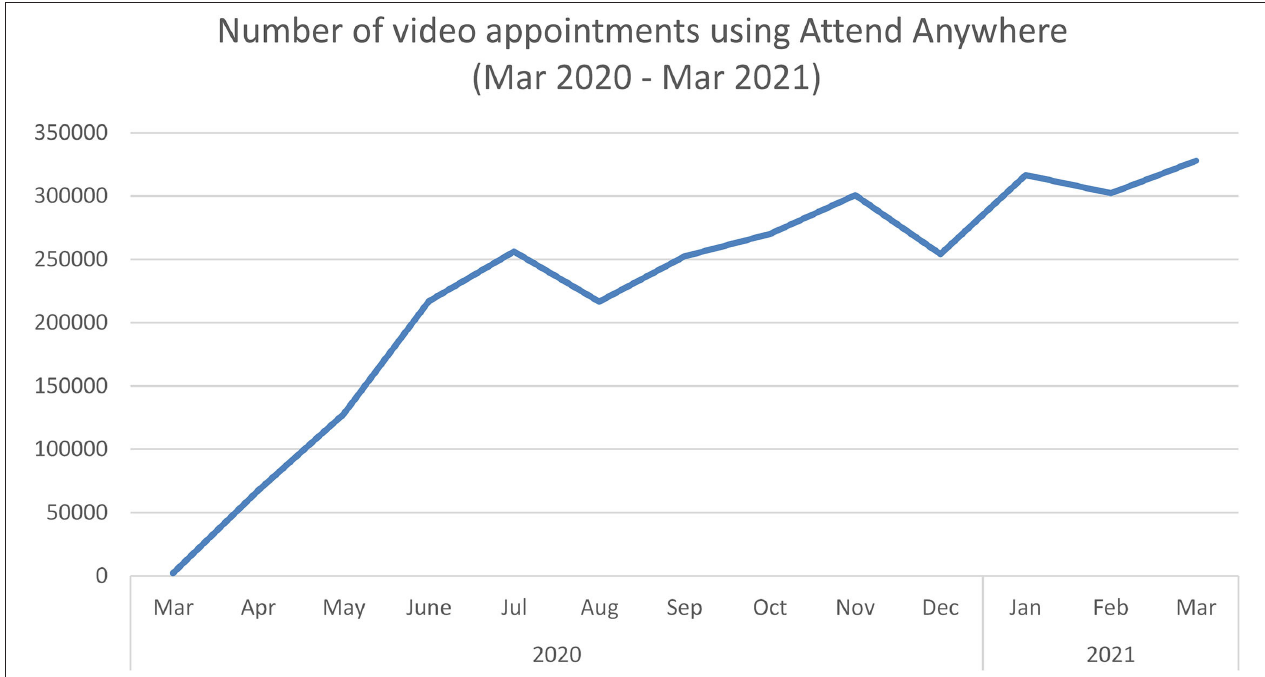
FIGURE 1 | Growth of video consultations during the pandemic. Graph shows total number of video consultations for NHS hospitals in England using the Attend Anywhere platform, March 2020 to March